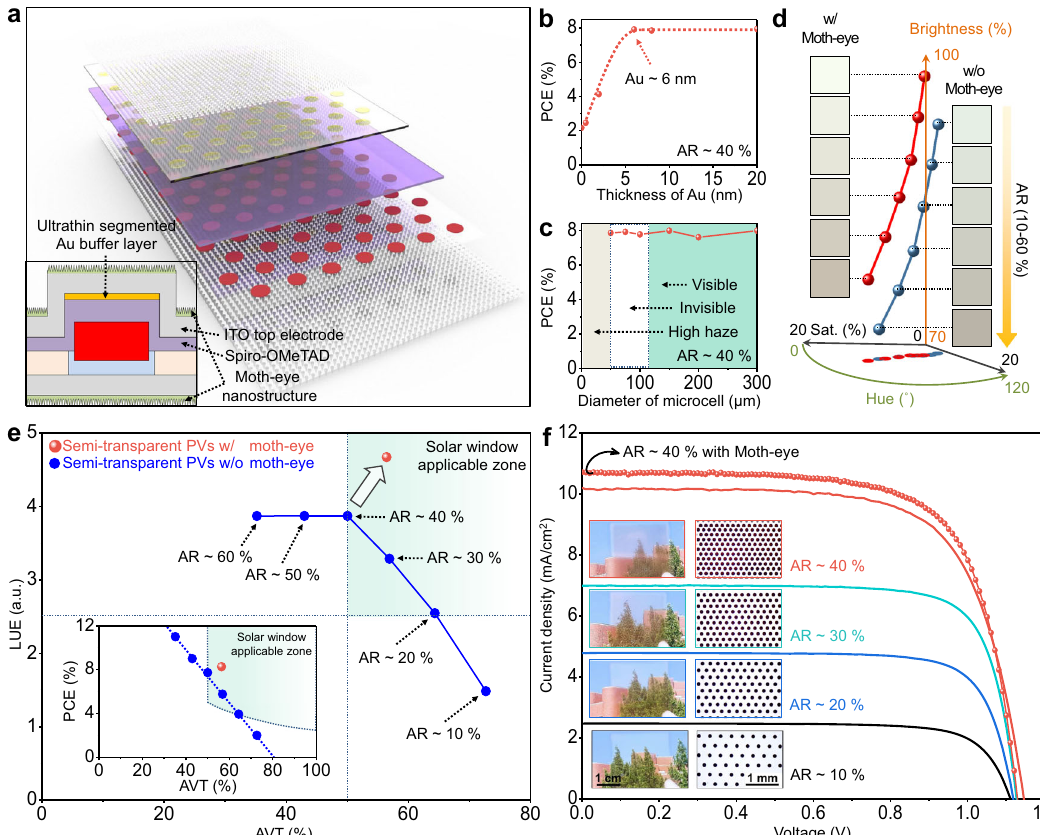
Fig. 4 Semitransparent PV with an ultrathin segmented Au buffer layer and moth-eye-inspired nanostructures. a Schematic exploded view of the semitransparent PV. The inset shows a magni fi ed cross-sectional view of the perovskite microcell in the semitransparent PV. b PCEs (reverse scan) of semitransparent PVs, depending on the thickness of the segmented Au buffer layer. The area ratio (AR) is fi xed at 40%. c PCEs (reverse scan) of semitransparent PVs, depending on the diameter of the microcell. The AR is fi xed at 40%. d Color representation and HSB color map of the semitransparent PV with and without the moth-eye nanostructures for various ARs (10 − 60%). e Light-utilization ef fi ciencies (LUEs) of semitransparent PVs with and without moth-eye nanostructures (red and blue circle, respectively) for various AVTs. The inset shows PCEs in Fig. 4e for various AVTs. PCEs obtained from the forward and reverse scan are averaged. The green zones in Fig. 4e and its inset represent the AVT and LUE criteria suitable for solar windows (AVT and LUE need to be over 50% and 2.5, respectively). f J – V characteristics of semitransparent PVs without (solid line) and with (dotted line) the moth-eye nanostructures (reverse scan). The inset shows optical camera (left) and microscopy (right) images of semitransparent PVs, depending on the